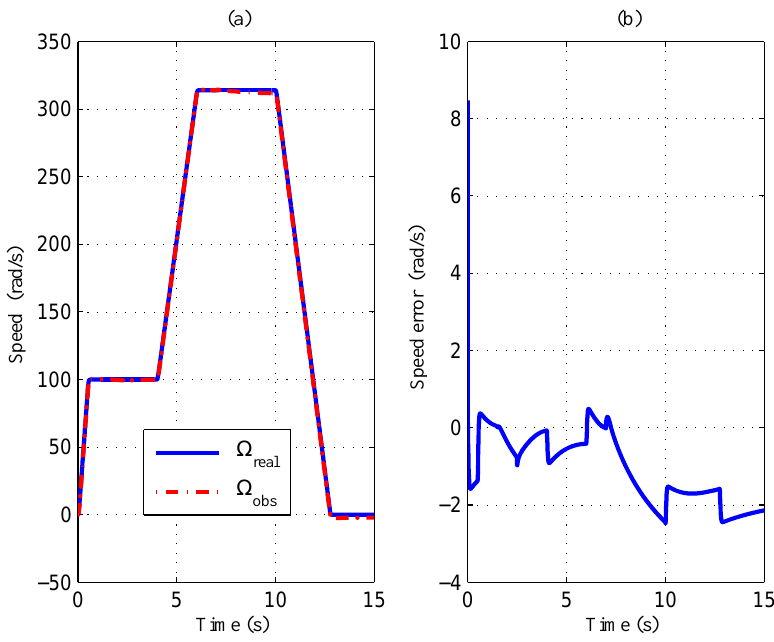
Figure 11. Robustness w.r.t. +20% L d , L q : ( a ) observed and measured speeds; and ( b ) speed error.